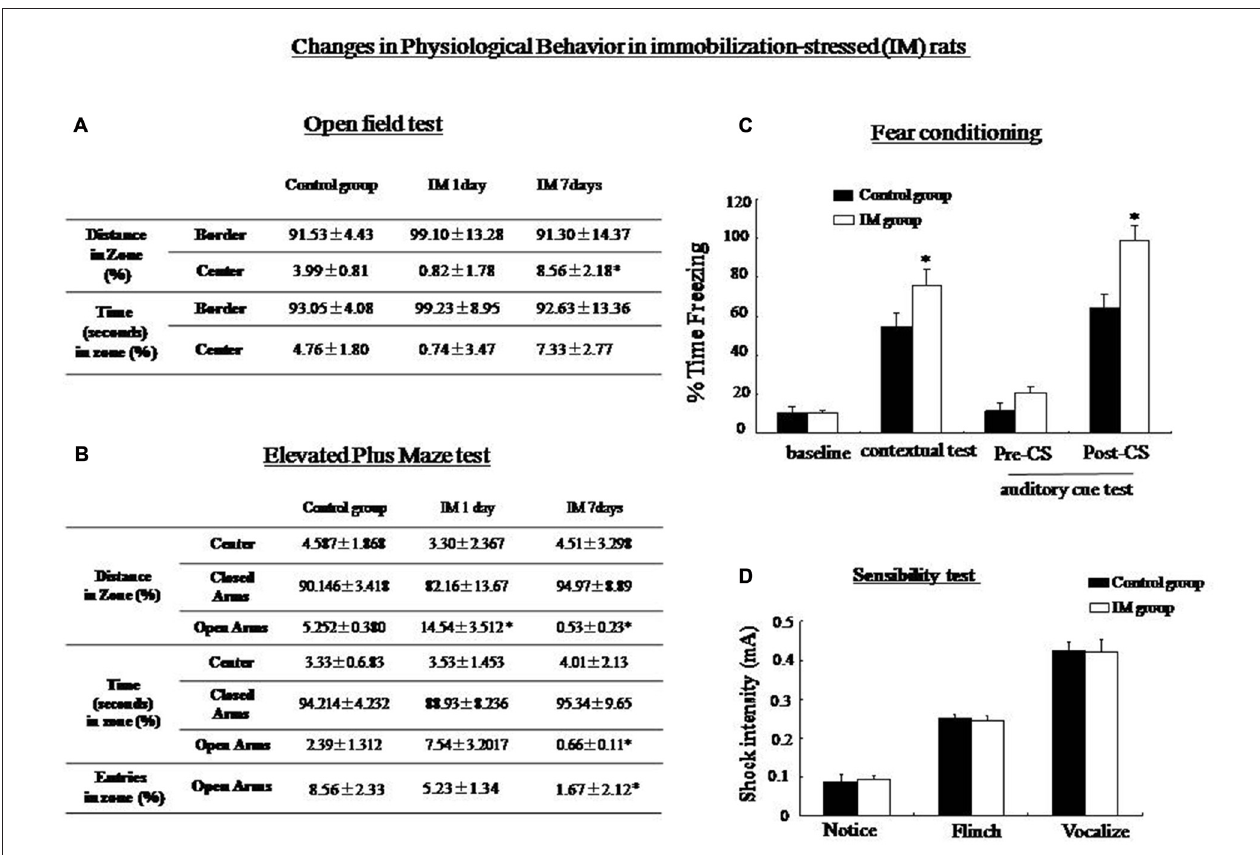
FIGURE 8 | (A) Open-field test: The immobilization (IM)-stressed rats showed a greater percentage of distance in the border zone compared with control rats. (B) Elevated plus maze: IM-stressed rats showed shorter distance, less time and less entry number in the open arm compared with control rats. (C) Conditioning test: The percentage of time spent freezing in contextual and auditory cue fear conditioning (post-CS) were significantly higher in the IM rats than in the control rats ( ∗ P < 0.05 vs. the control group). No significant difference was observed in baseline and pre-CS of the auditory cue fear conditioning between control and IM rats. (D) sensibility test to the foot-shock, no significant difference in minimum current strength which induced notice, flinch and vocalize was found between control and IM